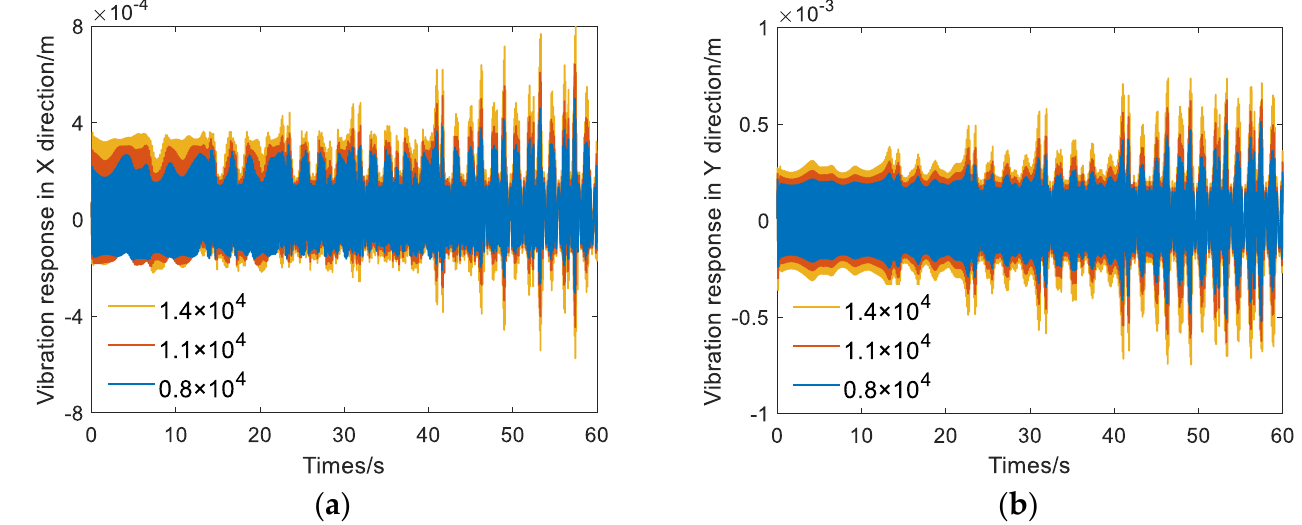
Figure 11. Shafting vibration response in the X and Y directions of the unit with different m 2 ; ( a ) shafting vibration response in X direction; ( b ) shafting vibration response in Y direction.